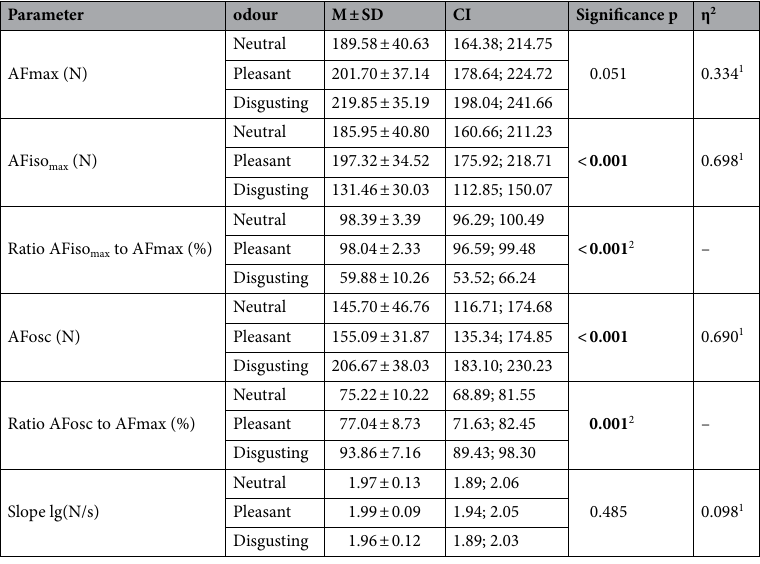
Table 2. Displayed are the arithmetic means (M), standard deviations (SD), lower and upper border of 95%-confidence intervals (CI) as well as the p-values and effect sizes η 2 of all parameters comparing the groups neutral, pleasant and disgusting odours. 1 Eta squared η 2 of RM ANOVA; 2 Friedman test. Significant results are displayed in bold.